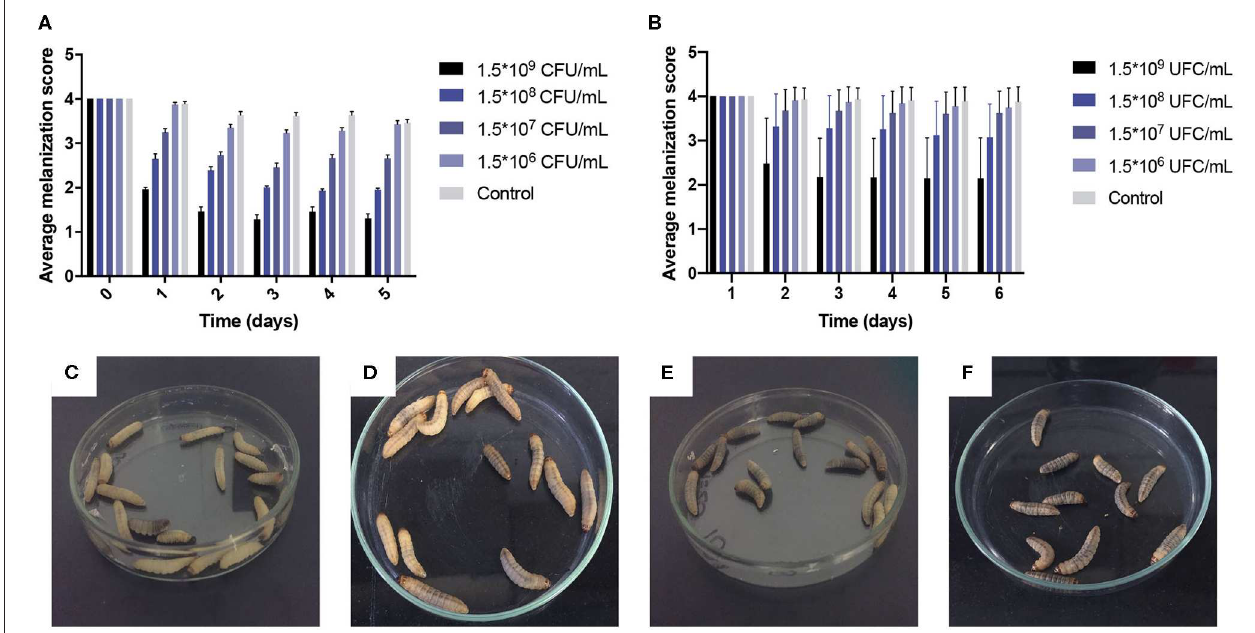
FIGURE 3 | Average melanization scores of larvae infected with M. furfur and M. pachydermatis at 37 ◦ C and melanization comparison between G. mellonella infected with M. furfur at 33 and 37 ◦ C on day 7. As can be seen, melanization score depends on time and treatment; scores decreased as inoculum concentrations increase ( p < 0.0001, 2-way ANOVA test). (A) Larvae infected with M. furfur. (B) Larvae infected with M. pachydermatis , moreover in (C) G. mellonella infected with 1.5 × 10 8 CFU/mL inoculum concentration of M. furfur and incubated at 37 ◦ C, melanization was scored as 2 with beige larvae; but in (D) G. mellonella infected with 1.5 × 10 8 CFU/mL inoculum concentration of M. furfur and incubated at 33 ◦ C, melanization score was recorded as two with darker larvae. Finally, in (E) G. mellonella infected with 1.5 × 10 9 CFU/mL inoculum concentration of M. furfur and incubated at 37 ◦ C showed larvae with lower melanization than (F) G. mellonella larvae infected with 1.5 × 10 9 CFU/mL inoculum concentration of M. furfur and incubated at 33 ◦ C. Larval melanization is higher in larvae incubated at 33 ◦ C.